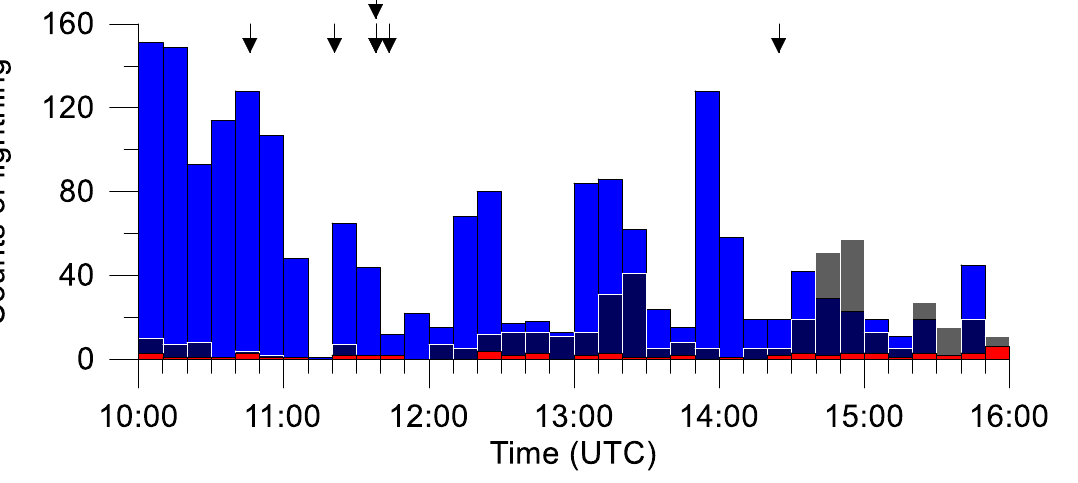
Figure 4. Time sequence of all sprite events and lightning activity every 10 min on 22 July 2013. The arrows indicate sprite occurrence times. The blue, gray, and red bars are counts of in-cloud lightning locations (VHF sources), − CGs, and +CGs, respectively.